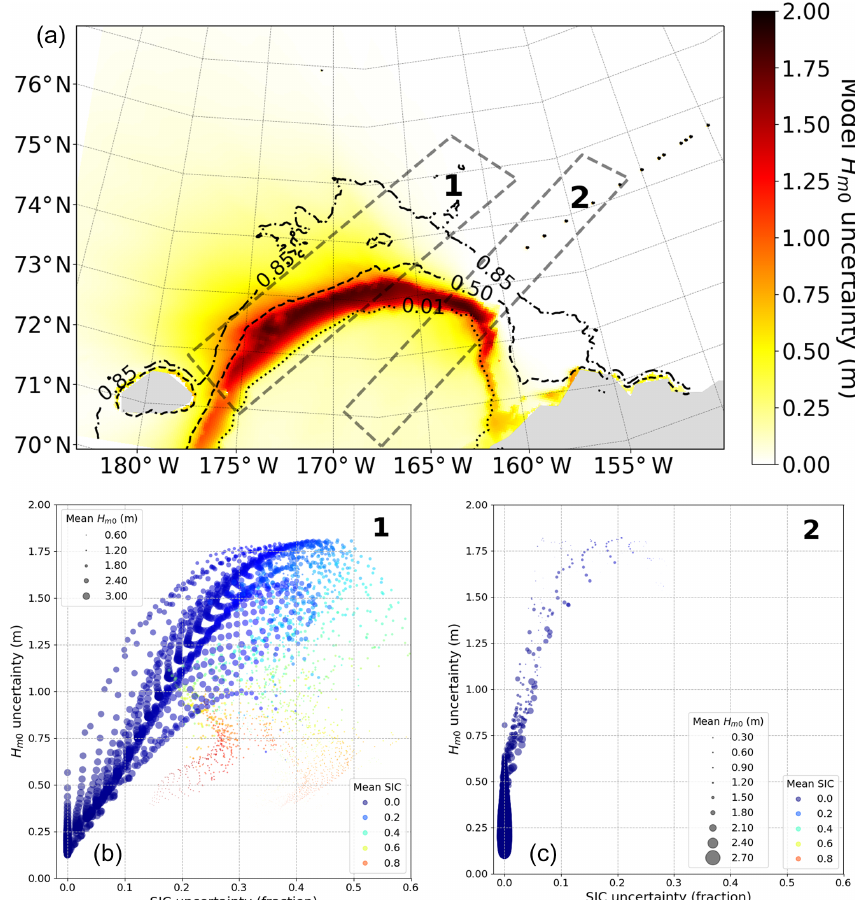
Figure 8. TodaiWW3-ArCS simulation on 21 November 2018, 21:00, during northeasterly off-ice wind conditions as shown in Fig. 6b. (a) (cid:49)H m map with 0.01 (dotted), 0.50 (dashed), and 0.85 (dash-dotted) mean( c i ) contours shown in black. (b) Bivariate model (cid:49)H m 0 (cid:49)c i uncertainty data shown in an enhanced scatter plot for the quadrilateral 1 area where the wind forcing is oriented along the ice edge. (c) Bivariate model (cid:49)H m and (cid:49)c i uncertainty data for the off-ice wave case for the quadrilateral 2 area. The schematics for panels (b) and 0 (c) follow Fig.